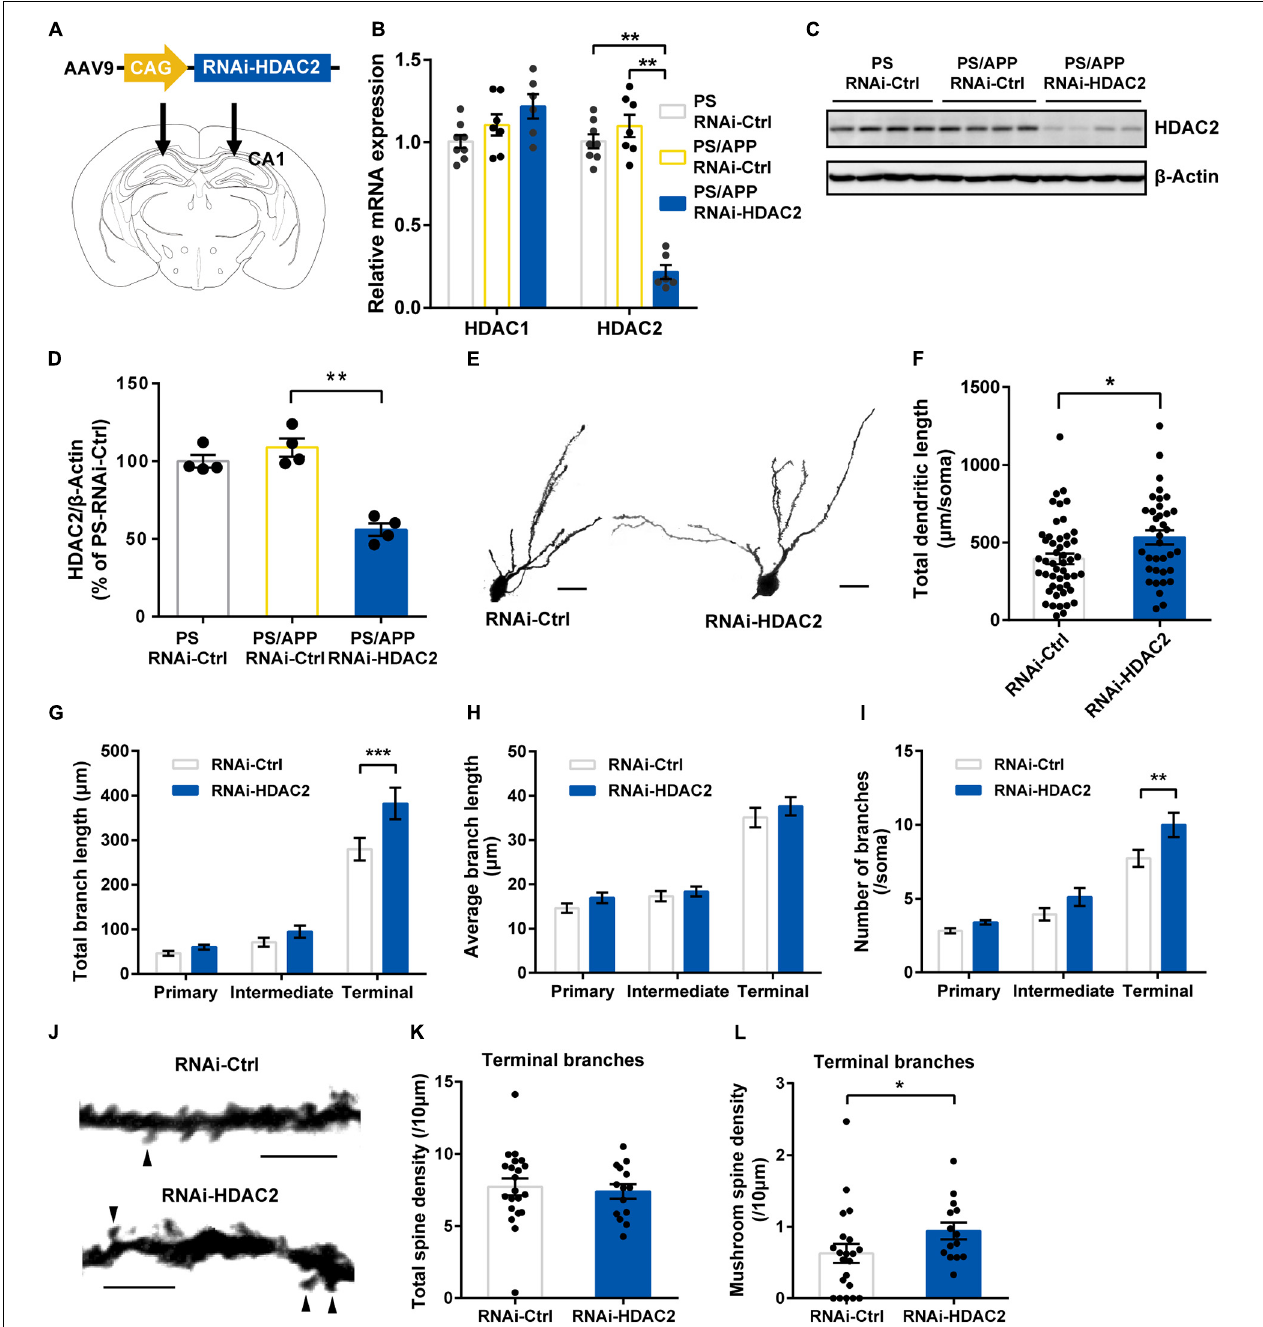
FIGURE 2 | Histone Deacetylase 2 silencing ameliorated morphological impairment in PS/APP mice. (A) Schematic representation of AAV-RNAi-HDAC2 and injection site. (B) Relative mRNA expression of HDAC1 and HDAC2 in the hippocampal CA1 region. HDAC2 mRNA level was decreased in PS/APP mice injected with AAV-RNAi-HDAC2. (C) Western blot analysis of HDAC2 proteins. Each band represents an individual mouse. HDAC2 protein level was decreased in PS/APP mice injected with AAV-RNAi-HDAC2. (D) Quantified western blots of HDAC2. AAV-RNAi-HDAC2 significantly suppressed HDAC2 protein expression. (E) Extracted representative images of CA1 basal dendrite. The scale bar is 20 µ m. (F) Total length of CA1 basal dendrites. HDAC2 silencing significantly increased total dendritic length in PS/APP mice. (G) Total length of each order of dendrite. HDAC2 silencing increased length of terminal branches. (H) Average length of each order of dendrite. There was no significant difference. (I) Number of branches at each order of dendrite. HDAC2 silencing increased number of branches of terminal dendrites. (J) Extracted representative pictures of spines on terminal branches. Arrowheads indicate mushroom spines. The scale bar is 5 µ m. (K) Density of total spines in terminal branches of CA2 basal dendrite. There was no significant change. (L) Density of mushroom-like spines in terminal branches of CA1 basal dendrite. HDAC2 silencing significantly increased mushroom-like spines. All data are presented as mean ± SEM. * p < 0.05, ** p < 0.01, and *** p < 0.001. Dunn’s multiple comparisons test for (B,D) , Mann Whitney test for (F,K,L) . Two-way repeated measure ANOVA, followed by Sidak’s multiple comparisons test for (G–I) .